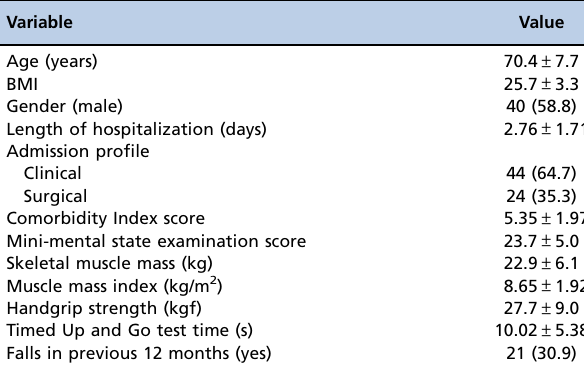
Table 1 - Baseline characteristics of the sample of 68 elderly hospitalized patients. Variable